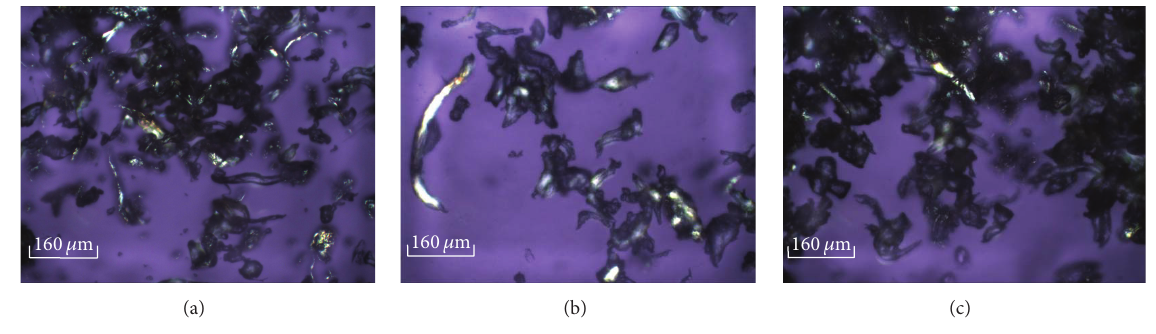
Figure 7: Polarizing microscope photos of GG (a), CLGG (b), and DCLGG